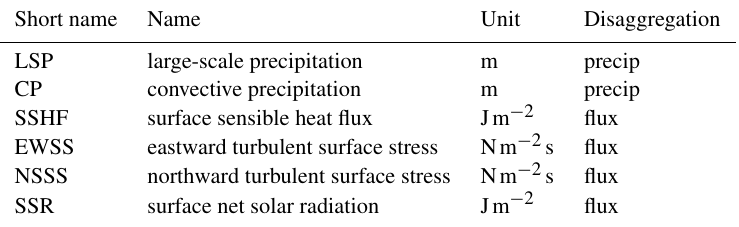
Table 13. List of flux fields retrieved by flex_extract and the disaggregation schemes (precip: Eq. 1 or Sect. 3.6.2, flux: Eq. 4)